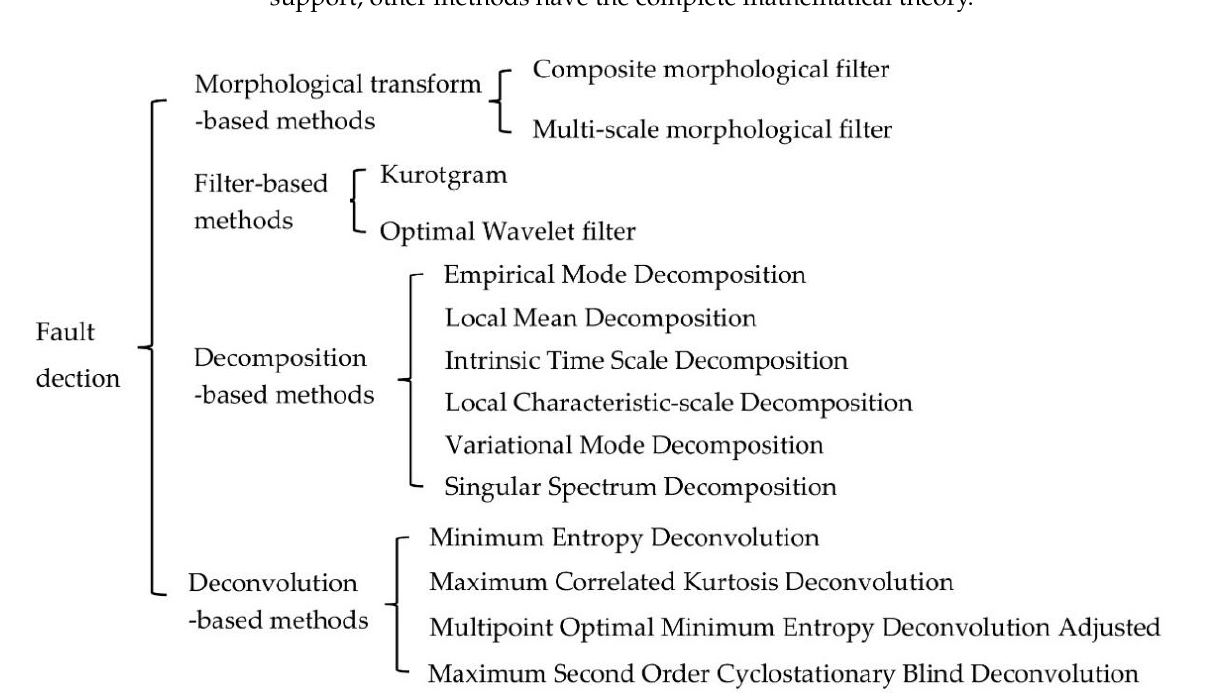
Figure 4. Summary of rolling bearing fault detection methods.